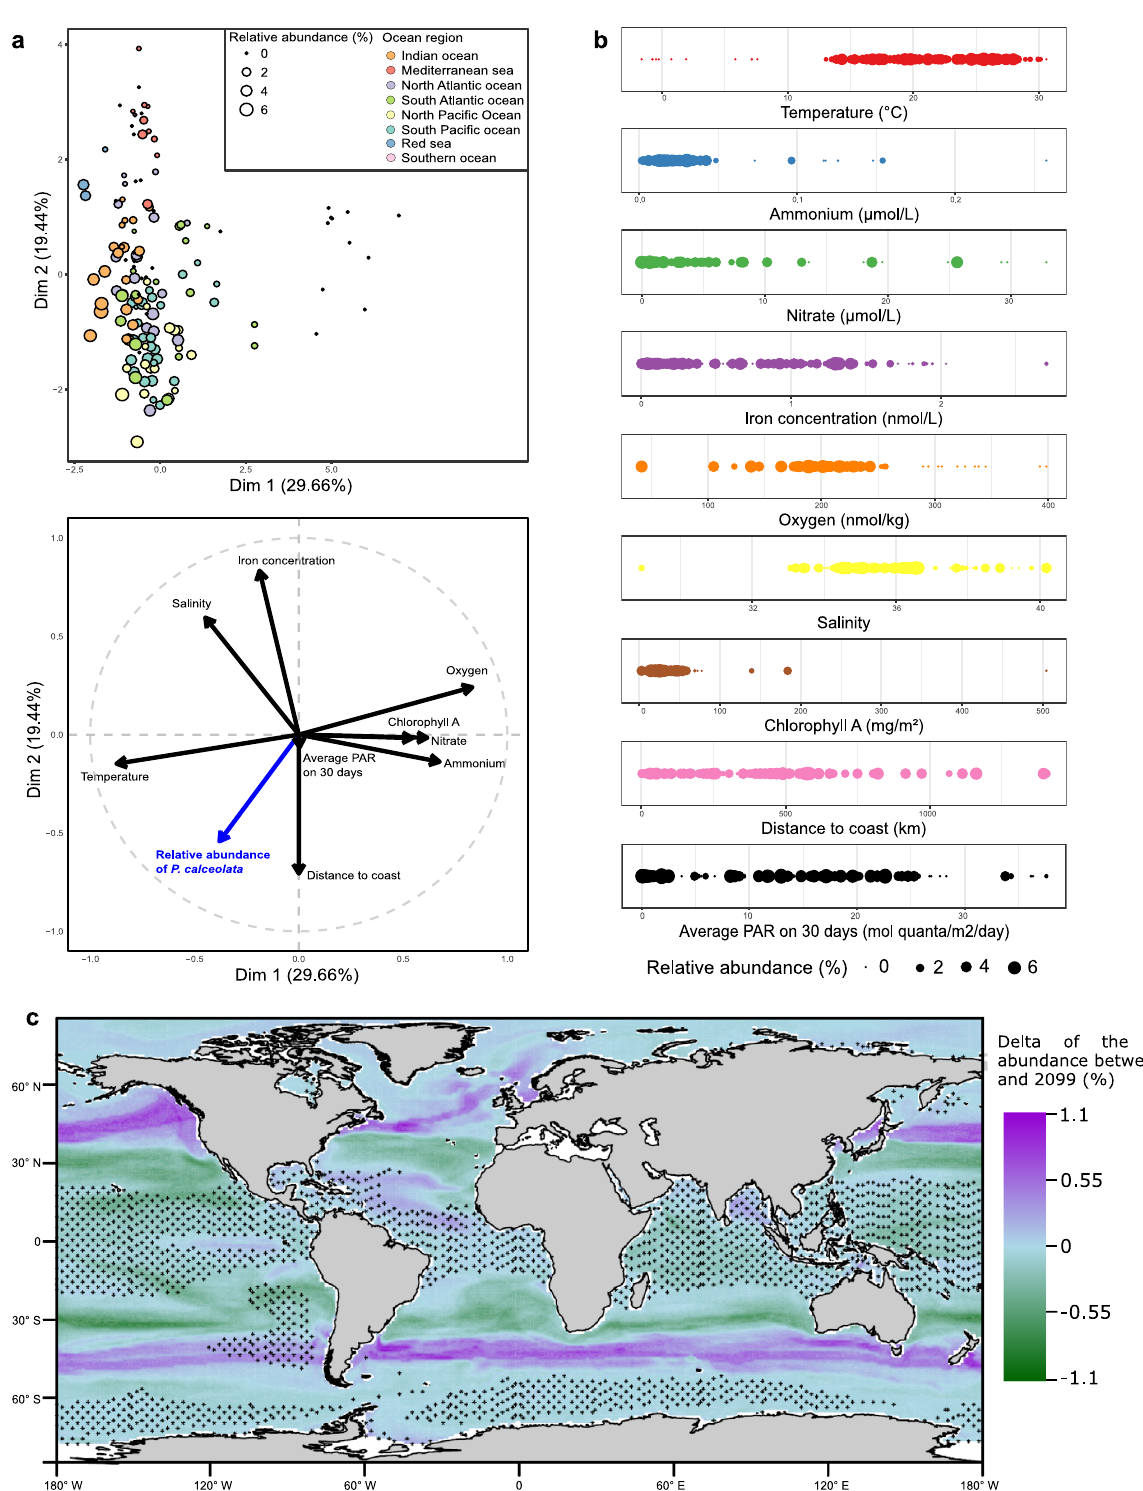
Fig. 3 Ecological niche of P. calceolata . a Principal component analysis of the metagenomic-based relative abundance of P. calceolata in the 0.8 – 5 µ m size fraction. Percentages of variance explained by each axis are indicated on axis titles. Top panel: each dot represents a sample with a size proportional to the relative abundance of P. calceolata and the colors indicate the oceanic basins. Bottom panel: nine environmental parameters are represented as vectors alongside the relative abundance of P. calceolata (blue vector). b Bubble plot of the relative abundance of P. calceolata for the 0.8 – 5 µ m size fraction according to the nine environmental parameters. c Delta of the modeled relative abundance of P. calceolata between 2010 and 2099. Green areas correspond to a decrease while purple areas correspond to an increase of P. calceolata relative abundance. Small stars indicate locations where at least one of the predictor drivers is out of range compared to the training dataset